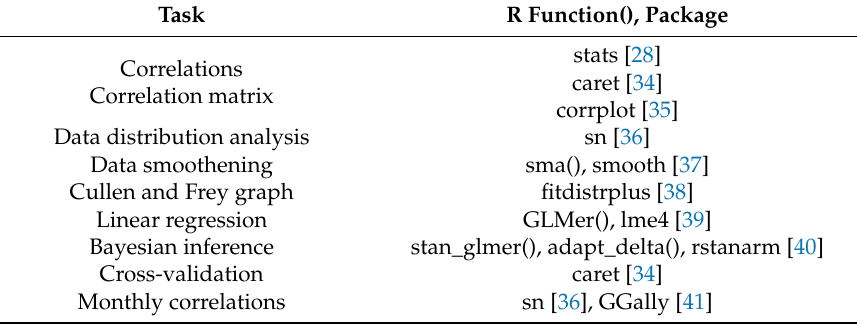
Table 2. Summary of tasks performed with related R functions and